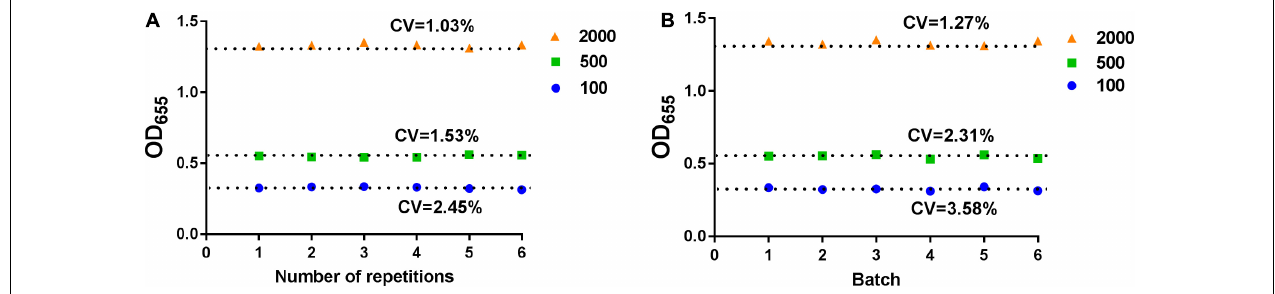
FIGURE 2 | The stability analysis for SP-device. The intra-batch (A) or inter-batch (B) analysis for SP-device. The low, medium, and high concentrations of NP in normal serum samples were measured by SP-device and the results were converted into OD 655 values.